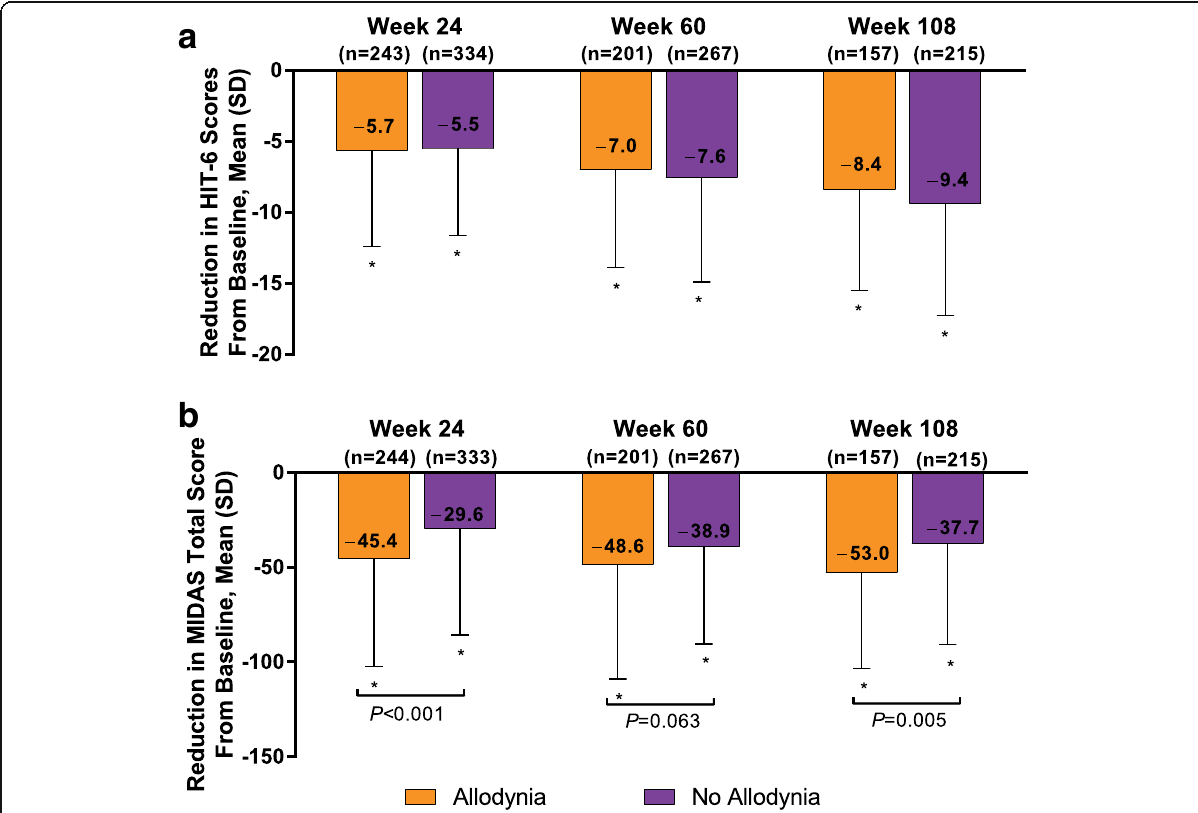
Fig. 2 OnabotulinumtoxinA effect on (a) HIT-6 and (b) MIDAS scores. HIT-6 = 6-Item Headache Impact Test; MIDAS = Migraine Disability Assessment questionnaire. *Indicates P < 0.001 for within-group comparison from baseline. P values shown in the figure indicate between- subgroup differences in change from baseline; data are observed